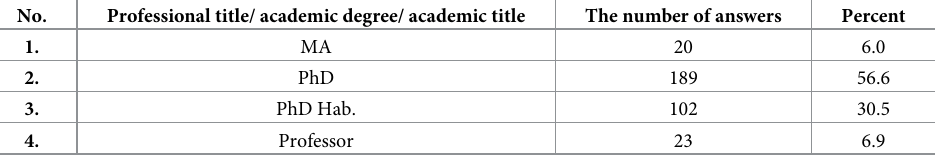
Table 2. Characteristics of the researched women on the basis of their professional title/degree/academic title. N = 334. Source: Study by Ewa Krause. No.